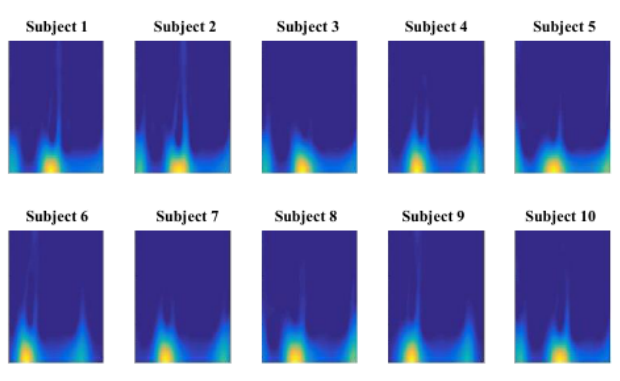
Figure 6. TF representation of gait samples as CNN